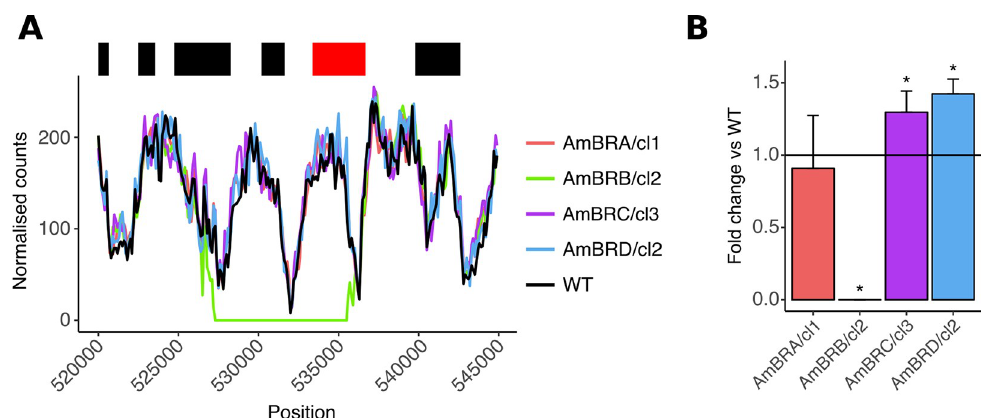
Fig 2. Deletion of the miltefosine transporter. A) Genome coverage at the transporter locus. Normalised mapped read count for 100 bp windows is plotted against genomic position on chromosome 13 (normalisation was achieved by adjusting counts by the ratio between total mapped read counts for chromosome 13 for that line compared to wild-type). The top banner shows local read positions as black boxes, with the exception of the miltefosine transporter ( LmxM . 13 . 1530 ), which is in red. B) Miltefosine transporter expression, as determined by qRT-PCR. Asterisks denote statistically significant differences (P < 0.05) in δ Ct from wild-type (P values for AmBRB/cl2, AmBRC/cl3 and AmBRD/ cl2 are 7.32 x 10 − 6 , 0.0165 and 0.00105, respectively), n = 3. See Methods for the statistical approach used.